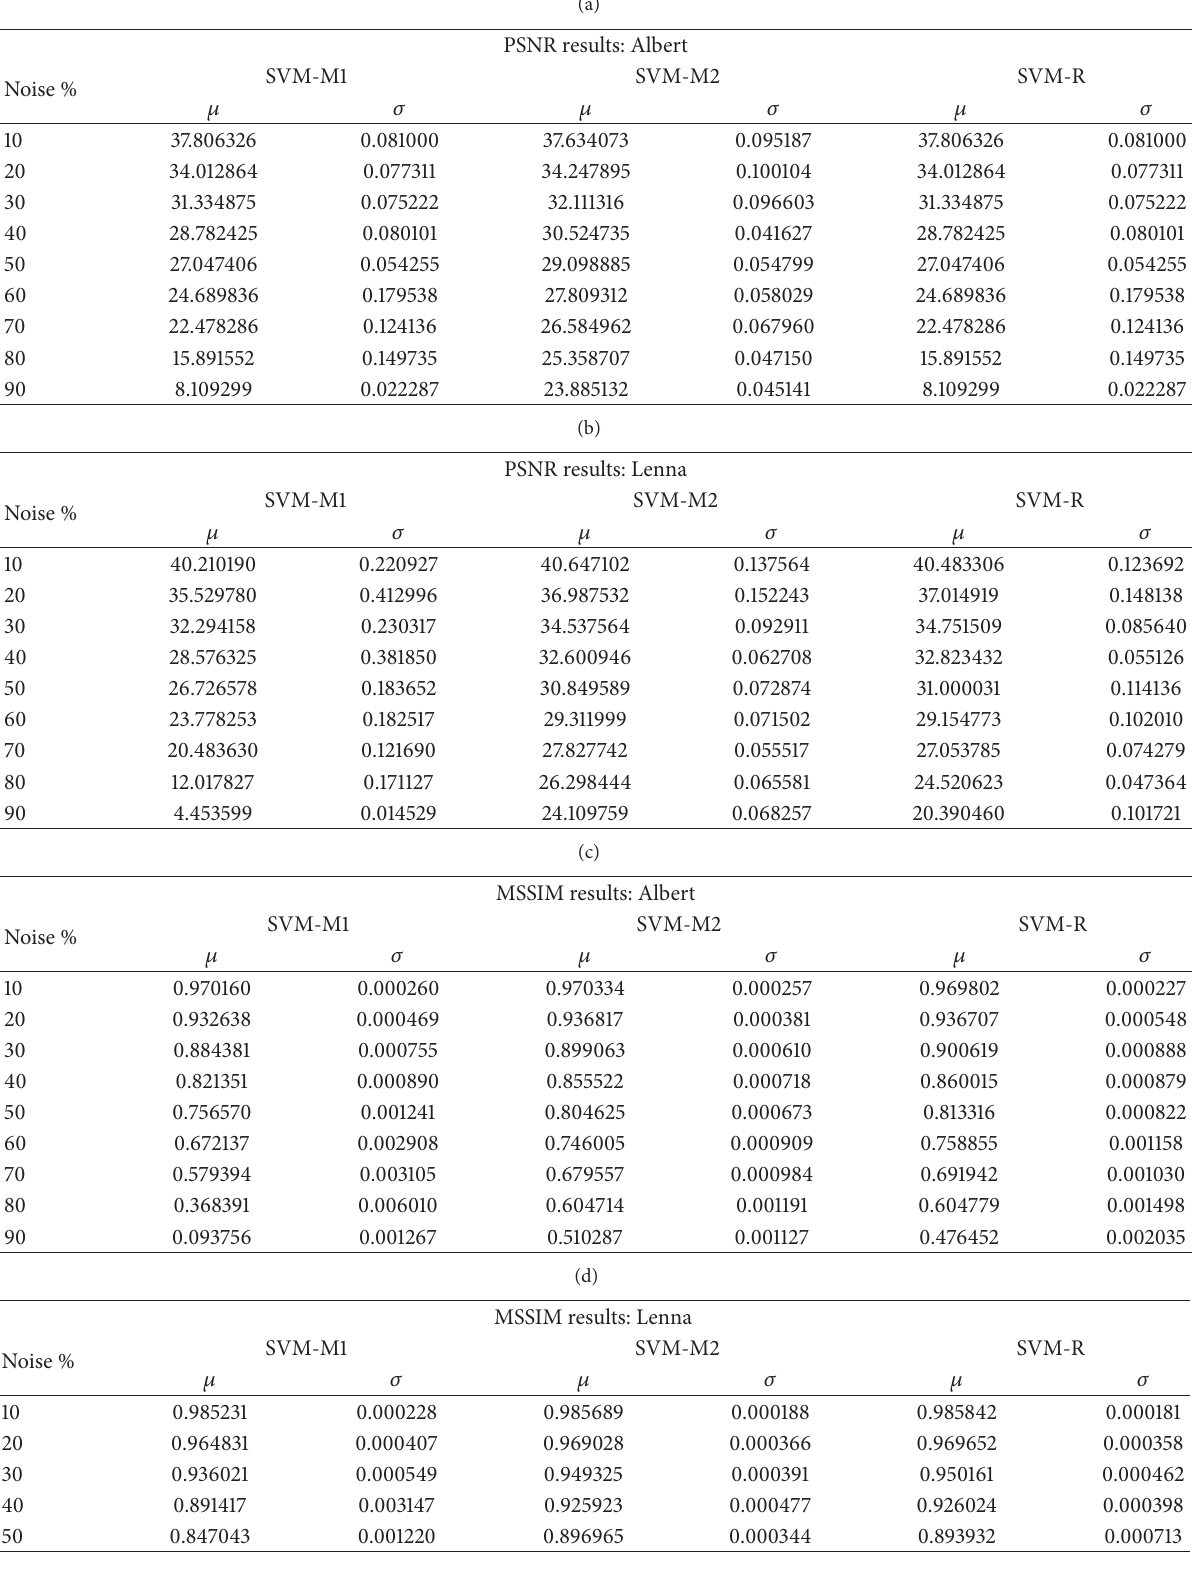
Table 5: Table results in PSNR and MSSIM for SVM methods. The model used in all cases is with 𝐻 = 32 and 𝑁 = 40 %. 𝜇 represents the mean and 𝜎 represents the standard deviation obtained using 10 different noise